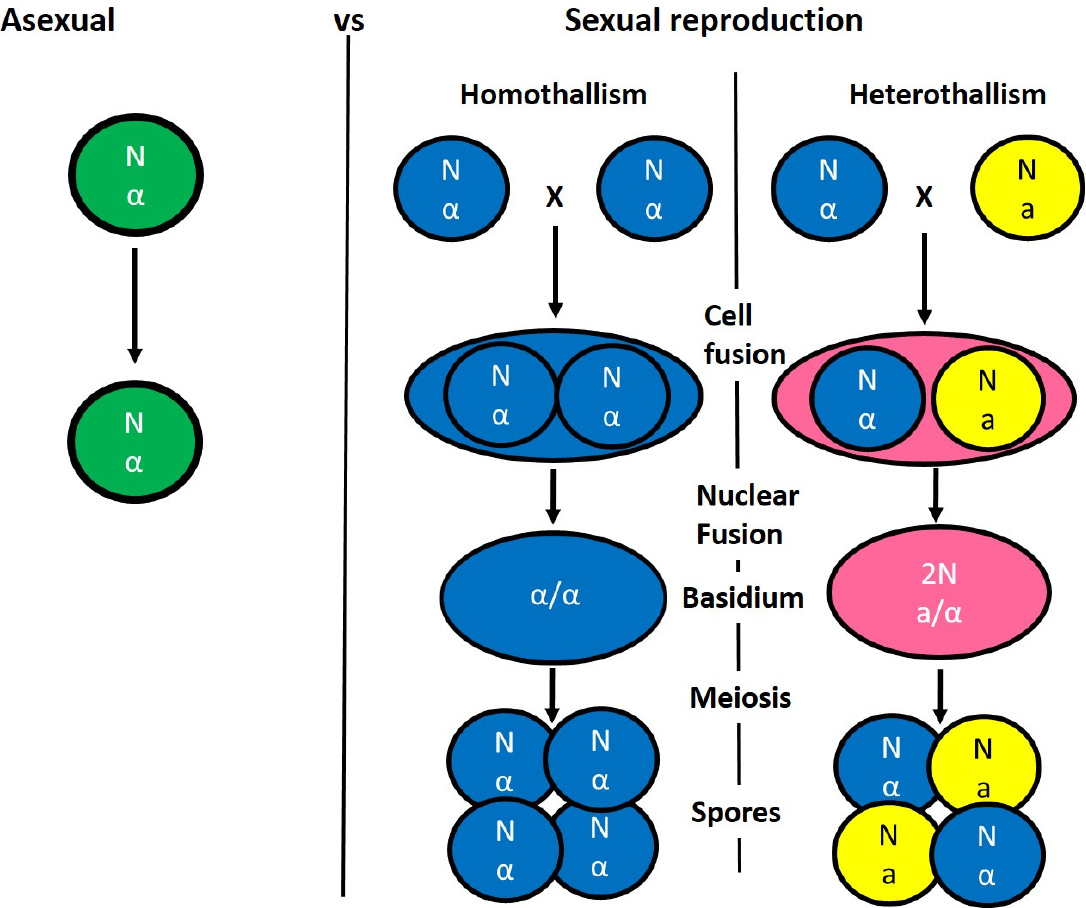
Figure 5. Reproduction in Cryptococcus neoformans . C. neoformans cells are generally haploid (N) and divide asexually (left panel) or enter a sexual cycle, (right panel). In the heterothallic mating, pheromone secreted between a and α cells results in cell fusion, where the nuclei do not fuse but form a filament called a dikaryon. The cell tips differentiate into basidia (2N). This is the site of nuclear fusion and meiosis. Multiple haploid cells are produced following further rounds of mitotic divisions.